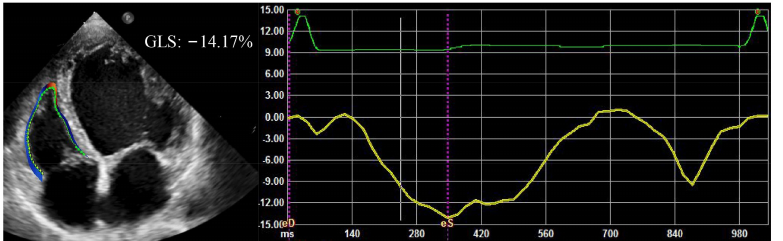
Figure 2. RVGLS in a patient with HFrEF. RVGLS, right ventricular global longitudinal strain.